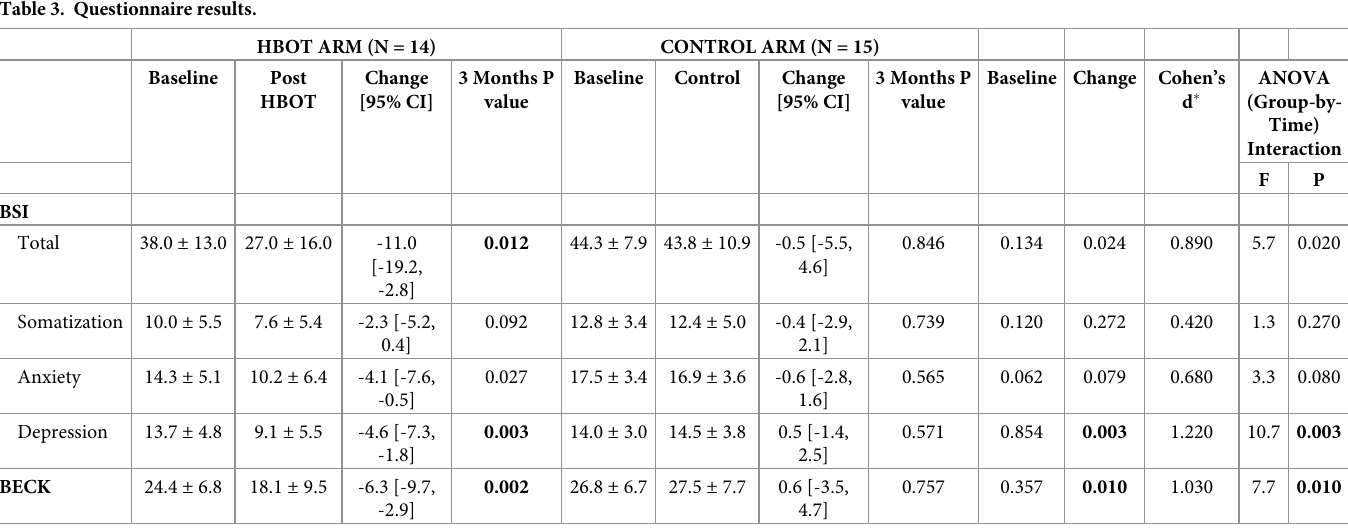
Table 3. Questionnaire